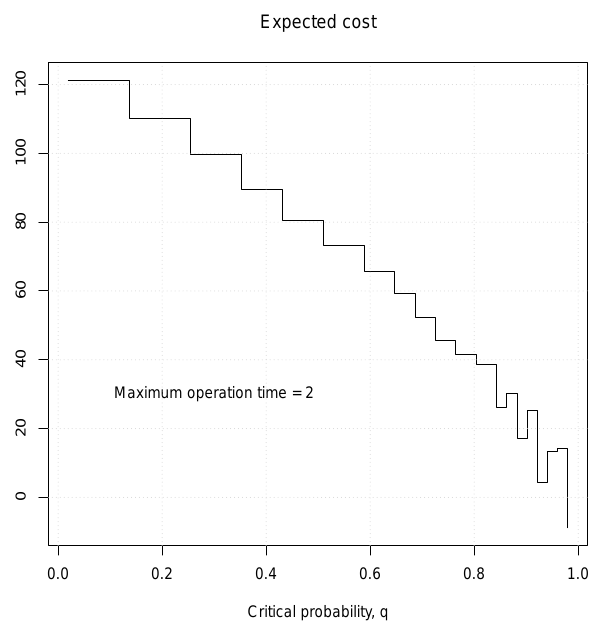
Figure 4. 2 oo 3 voting system. ( Left panel ): Optimal time to PM. ( Right panel ): Optimal maintenance cost.